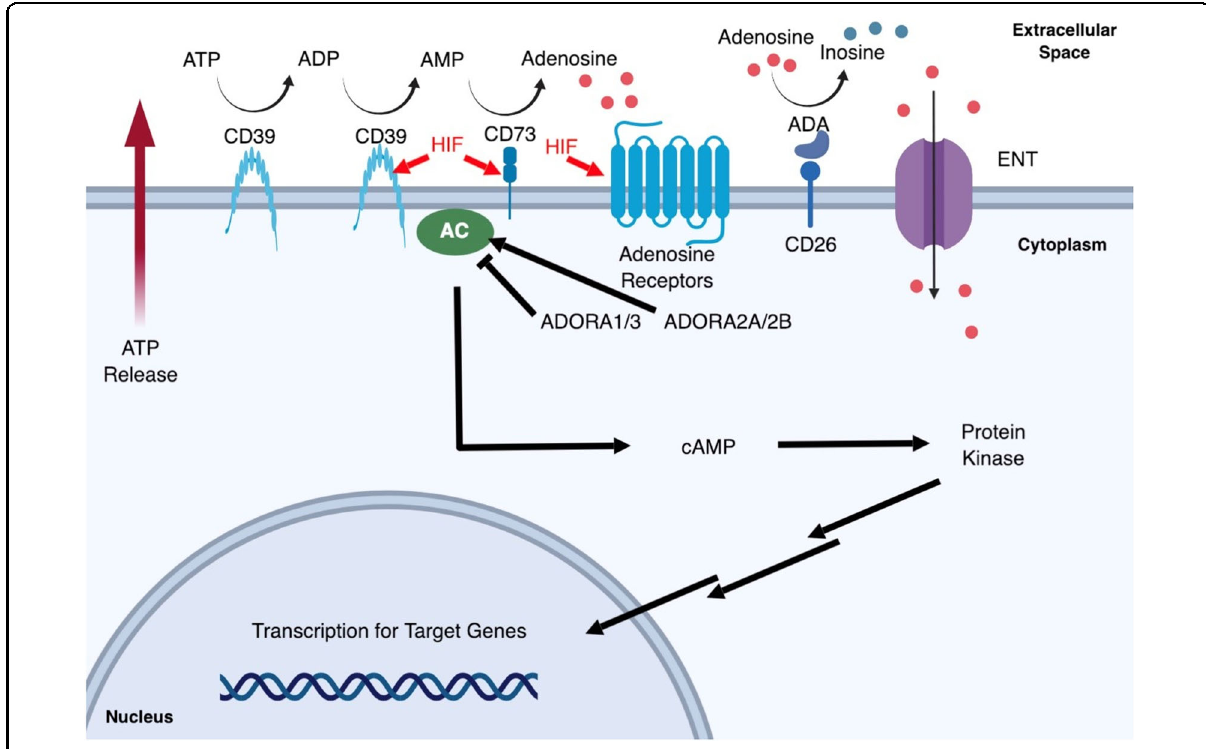
Fig. 2 Adenosine signaling pathway. During the hypoxic insult, cells release adenosine triphosphate/adenosine diphosphate (ATP/ADP) that accumulate in the extracellular space. Hypoxia triggers the SP1-dependent induction of CD39 and HIF-dependent induction of CD73, which converts ATP to ADP, AMP, and eventually adenosine. HIF also upregulates adenosine receptor levels and together with the increased extracellular adenosine, the downstream purinergic signaling pathway is activated. Extracellular adenosine could re-enter into the cell by equilibrative nucleoside transporters (ENTs) or could be deaminated by CD26-conjugated adenosine deaminases (ADAs), all of which function to terminate adenosine signaling. Stimulation of adenosine receptors either result in the inhibition of adenylyl cyclase (AC) by ADORA1/3 or activation by